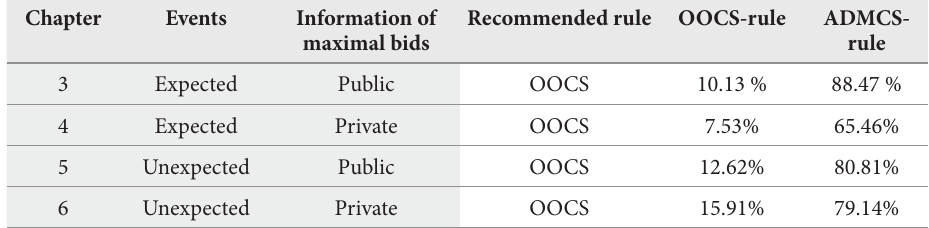
Table 5. The average deviation ratios for the OOCS-rule and ADMCS-rule, collected from the 4 experi- ments Chapter